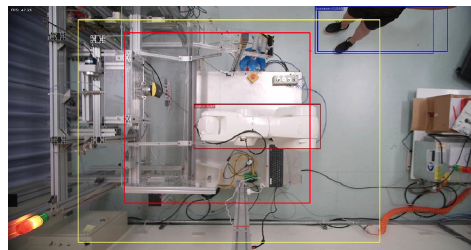
Figure 14. Person enters warning range.